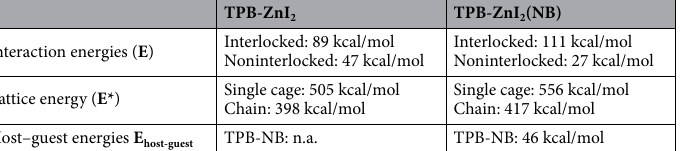
Table 1. Computed DFT energy interactions in 1 without ( TPB-ZnI 2 ) and with ( TPB-ZnI 2 (NB) ) included nitrobenzene (NB) solvent.